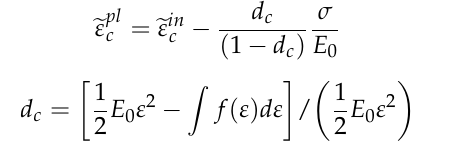
Figure 10. Creep-time curve of specimen TBB5.